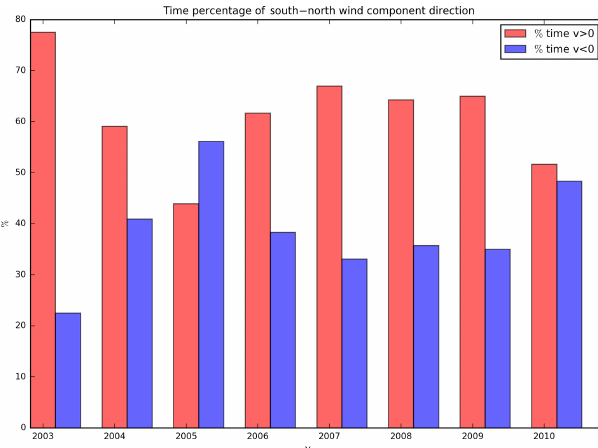
Figure 17. Statistics on the northerly and southerly winds during winters (January–February–March). Based on atmospheric forc- ings, the percentages of occurrence of northerly (in blue) and southerly (in red) winds are